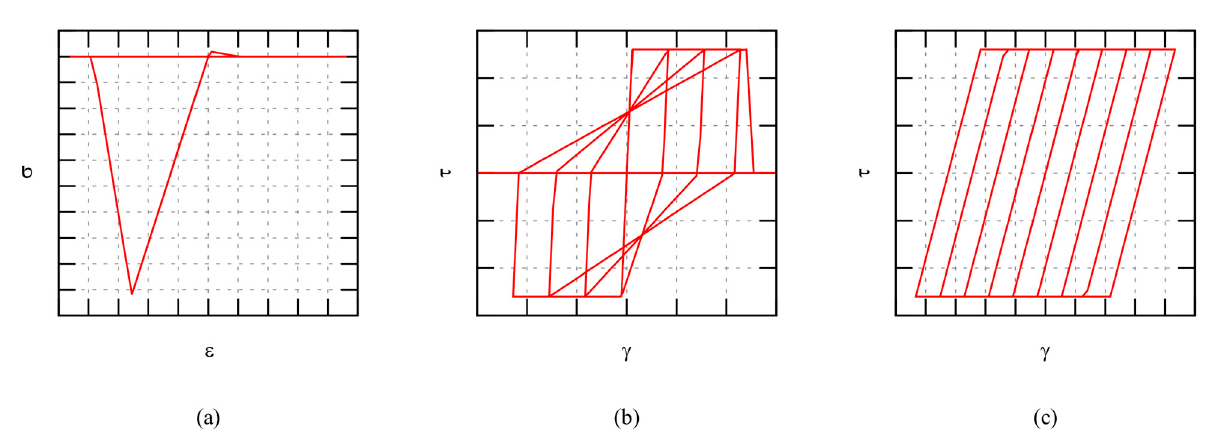
Figure 9. Typical cyclic constitutive laws used for nonlinear springs in DMEM: ( a ) tension/compression (rocking), ( b ) shear in the block and ( c ) sliding.